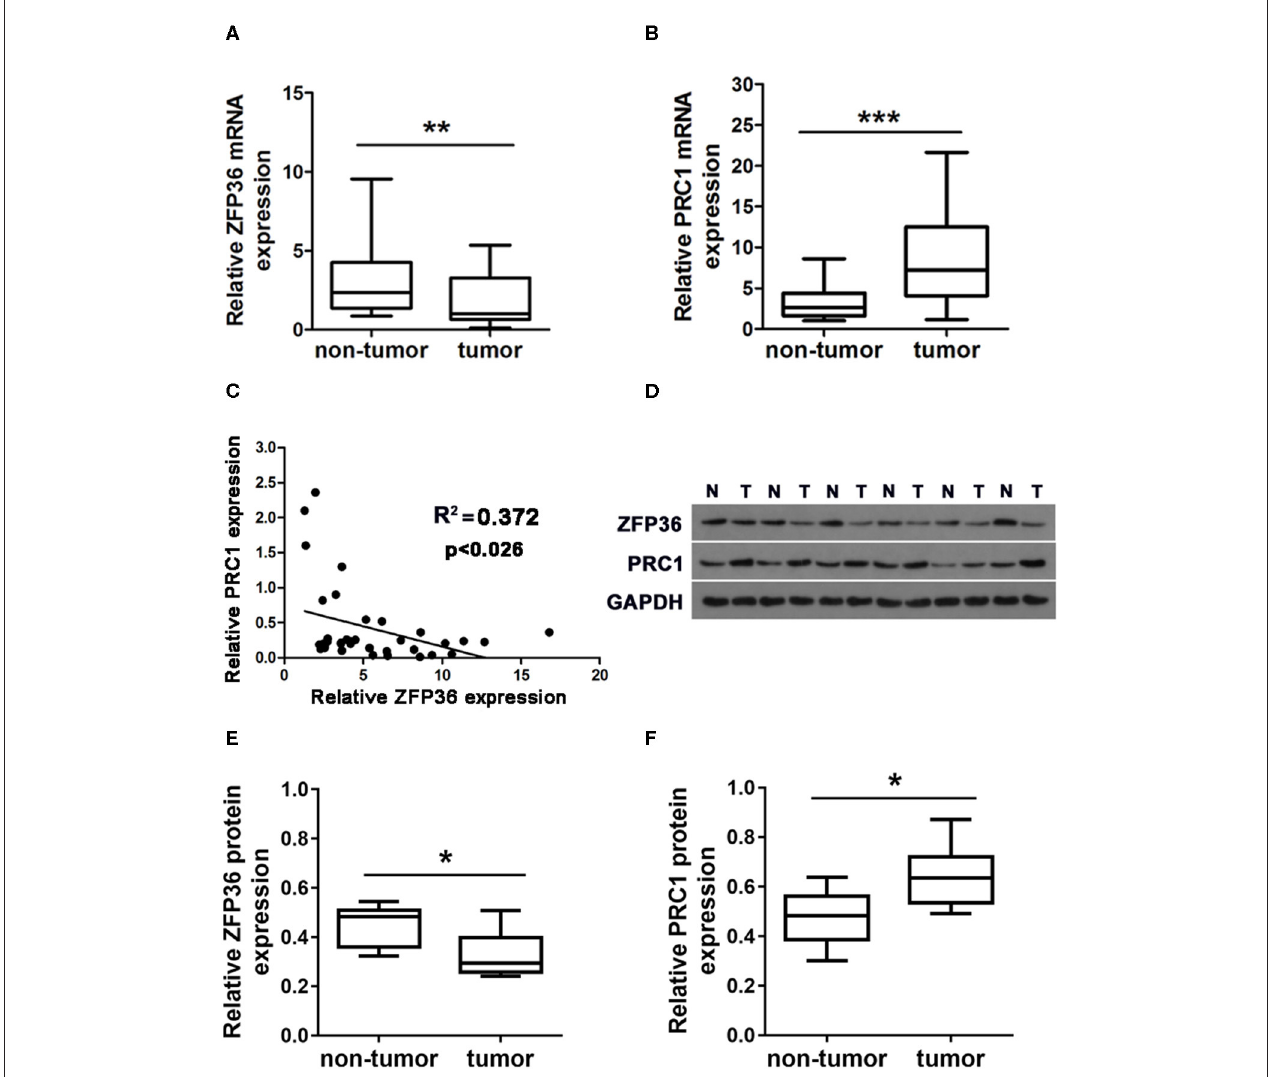
FIGURE 1 | The expression of ZFP36 and PRC1 in hepatocellular carcinoma tissues. (A,B) ZFP36 and PRC1 expression in 35 paired hepatocellular tumor and adjacent non-tumor tissues analyzed by qRT-PCR ( N = 35). (C) The relationship between ZFP36 expression and PRC1 expression was detected by Spearman correlation analysis ( R = − 0.372, ** p < 0.026). (D) Six pairs of representative bands of ZFP36 and PRC1 protein expression in hepatocellular carcinoma tissues and adjacent non-tumor tissues analyzed by western blots. (E,F) Quantifications of the density of western blots were determined by Image J ( N = 6). (* p < 0.01, ** p < 0.01, *** p <